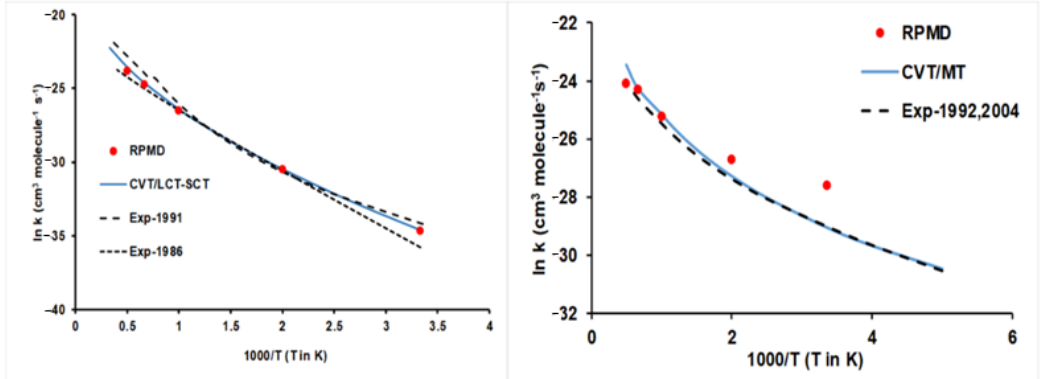
Figure 9. Arrhenius plots of the O( 3 P) + C 2 H 6 ( left panel ) and OH + C 2 H 6 ( right panel ) thermal rate constants (cm 3 molecule − 1 s − 1 ). Blue line: CVT/MT rate constants; red circles: RPMD rate constants. In the left panel, black dashed line: experiment from Refs. [91,92]. In the right panel, experimental values from Refs. [86,93].